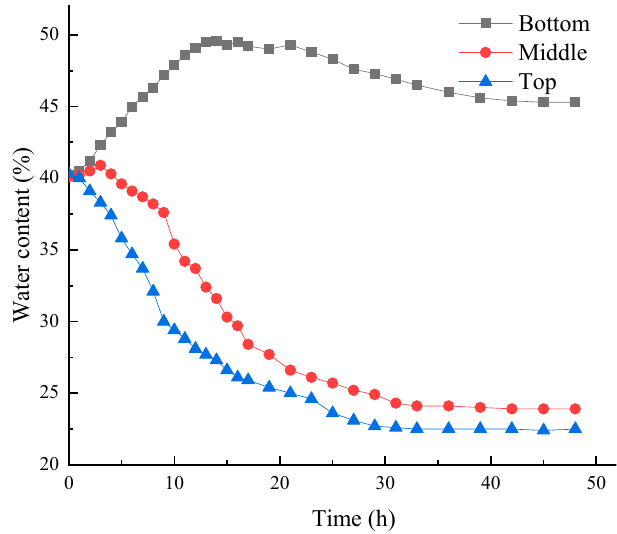
Figure 7. Variation curve of water content with time at monitoring points of bottom-up electro-osmosis.